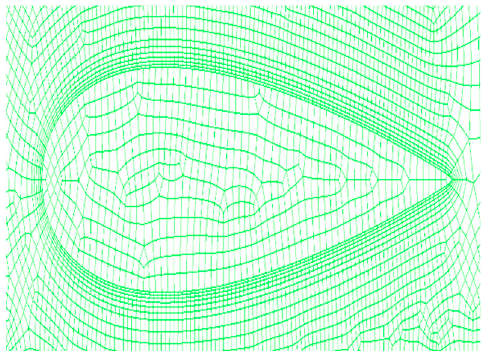
Figure 3. The zoomed-in image of the mesh and boundary layer.